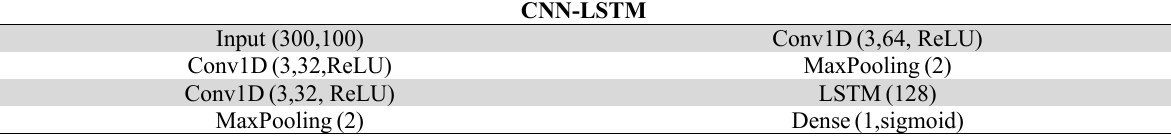
The architecture of the CNN-LSTM